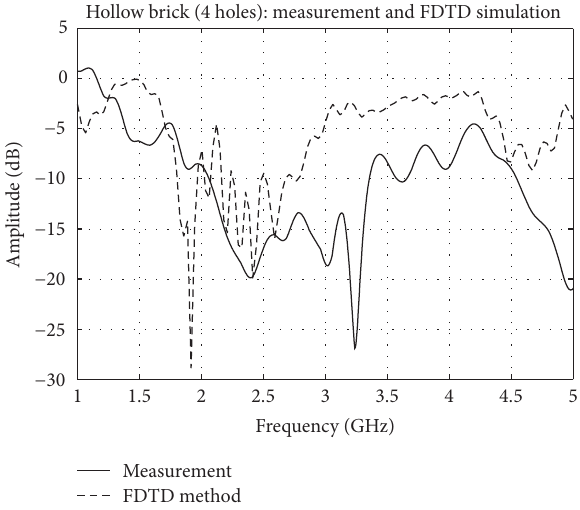
F 3: Transmission coefficient comparison between 1D electro- magnetic model and FDTD model.